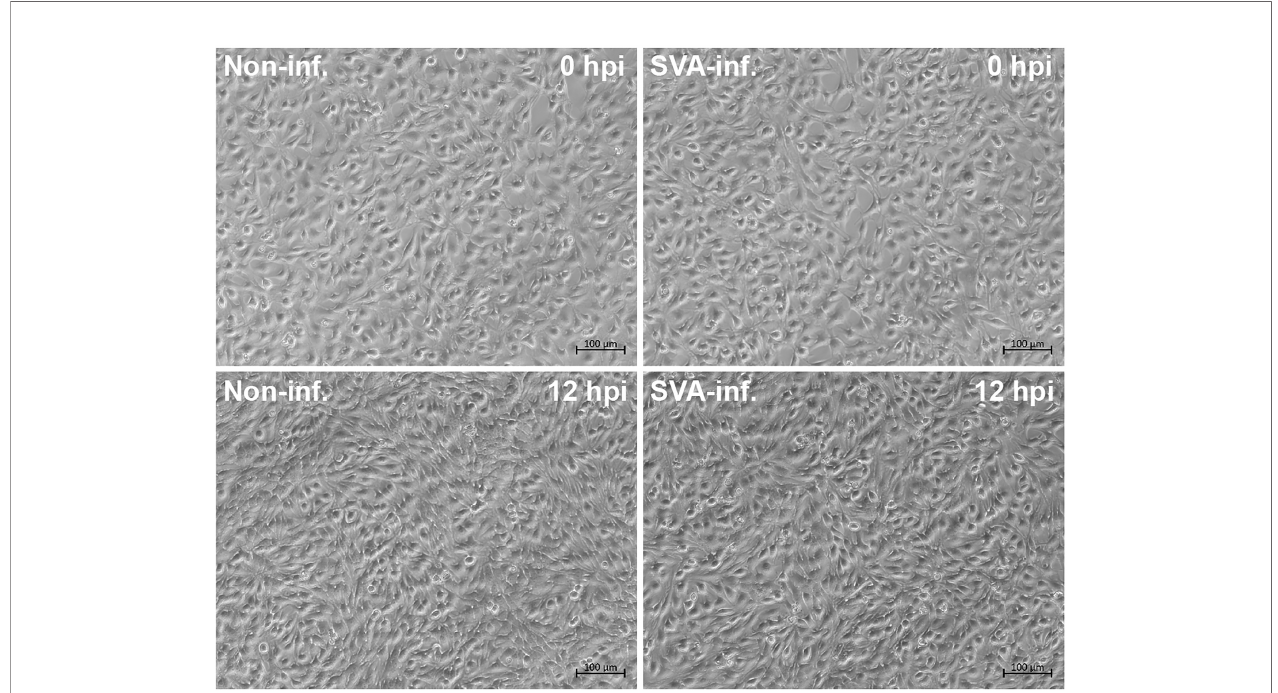
FIGURE 1 | SVA- and non-infected BSR-T7/5 cell monolayers at 0 and 12 hpi. The rescued wild-type SVA at passage-5 is used for inoculation of cells at multiplicity of infection of